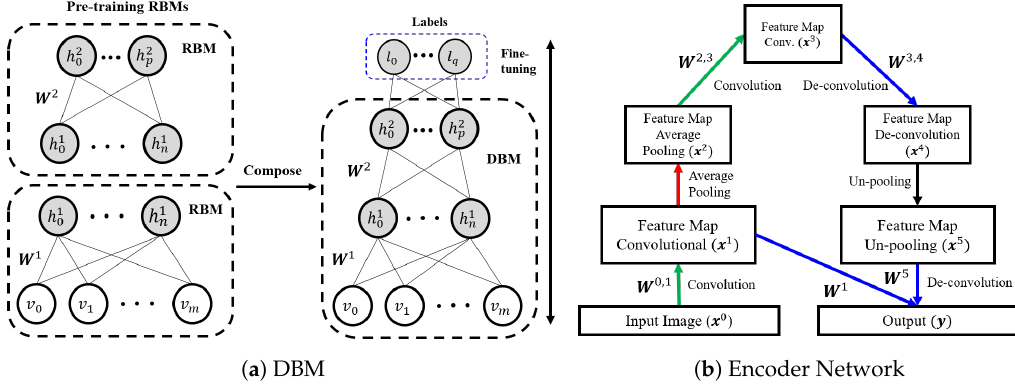
Figure 2. Illustrations of ( a ) DBM and ( b ) convolutional encoder network (CEN) used in this study. In ( a ), two RBMs are stacked together for pre-training ( left ) to form a DBM ( right ). In ( b ), input image is encoded by using two convolutional layers and an average pooling layer and decoded to WMH segmentation using two de-convolutional layers and an un-pooling layer. This architecture is inspired from